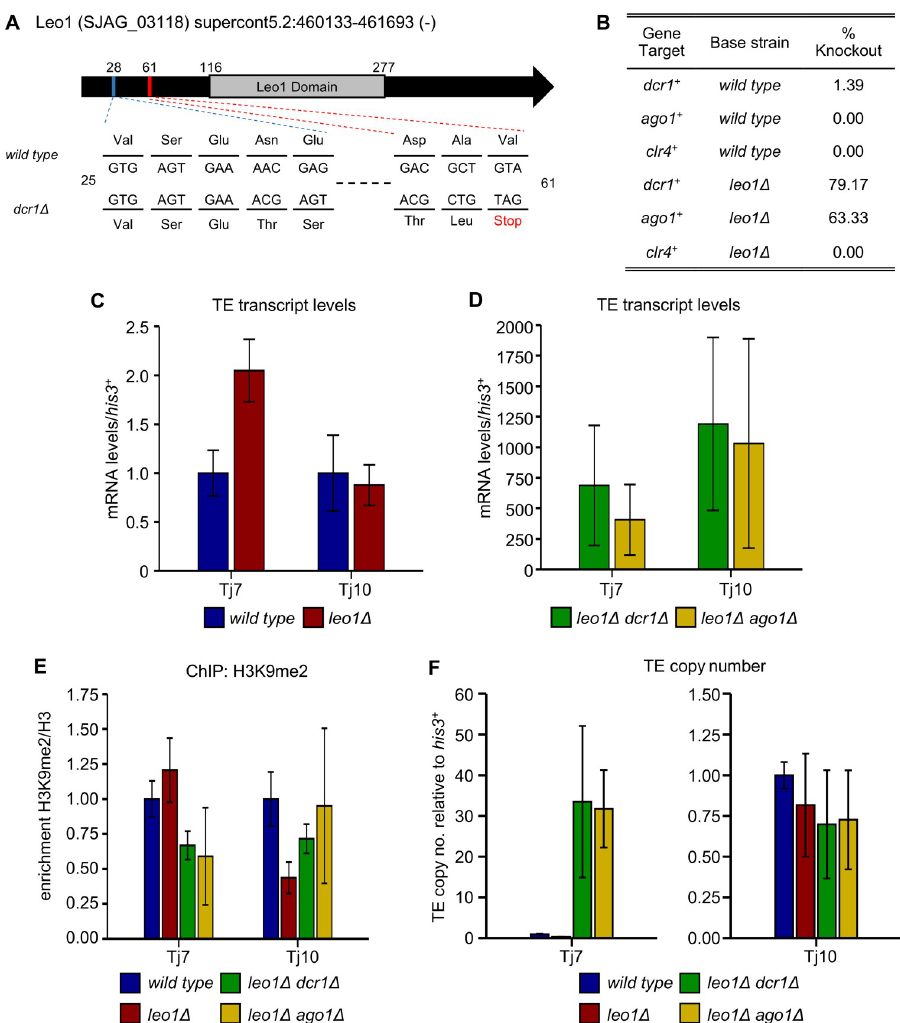
Fig 4. Mutation of the Paf1 complex subunit Leo1 facilitates survival of RNAi mutants. (A) Schematic showing the location of the sequenced mutation within Leo1. The single base pair deletion causes a frameshift, which leads to the introduction of a premature stop codon after 61 amino acids. (B) Knockout recovery rates of core RNAi and heterochromatin factors in wild-type and leo1 Δ backgrounds. (C) RT-qPCR analysis of retrotransposon transcript levels in wild-type and leo1 Δ strains, relative to his3 + , normalised to wild-type. Data plotted are the mean ± SD from three replicates. (D) RT-qPCR analysis of retrotransposon transcript levels in leo1 Δ dcr1 Δ and leo1 Δ ago1 Δ strains, relative to his3 + , normalised to wild-type. Data plotted are the mean ± SD from three replicates. (E) ChIP-qPCR analysis of H3K9me2/H3 levels at Tj7 and Tj10 retroelements, relative to his3 + , normalised to wild-type. Data plotted are the mean ± SD from three replicates. (F) qPCR analysis of retrotransposon copy number, relative to his3 + , normalised to wild-type. Data plotted are the mean ± SD from three